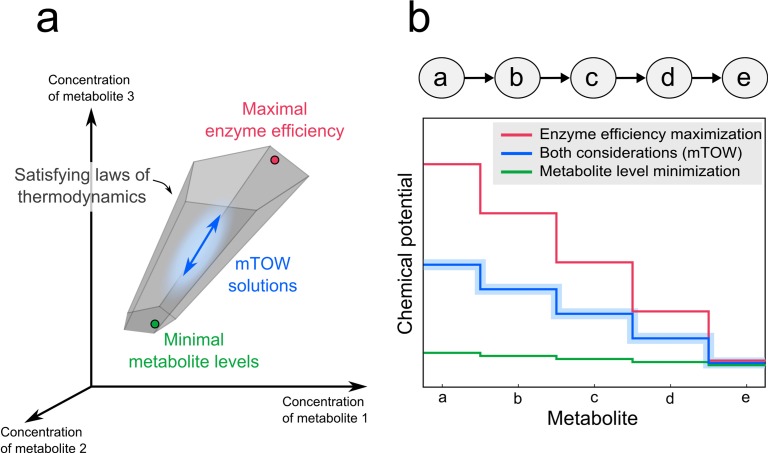
Steady-state metabolite concentrations reflect a balance between minimizing metabolite levels versus maximizing enzyme efficiency.(a) The second law of thermodynamics alone is insufficient to uniquely determine metabolite concentrations, resulting in a space of possible metabolite levels. Two factors “pull” metabolite levels within this space in different directions: (I) a limitation of the solvent capacity and osmotic pressure that tends to drive metabolite concentrations down; (II) the cost associated with the production of enzymes that drives up ratios of reactant-to-product concentrations, and thereby total metabolite concentrations. (b) A toy example of a linear pathway. The chemical potential of each metabolite in the pathway depends on its concentration and intrinsic energy of formation. A drop in metabolite chemical potential at every step is a thermodynamic requirement for the pathway to carry flux. Considering only the objective of maximizing enzyme efficiency (i.e., forward flux per enzyme), it is desirable to achieve a large drop in chemical potential at each step, but this requires unrealistically high total metabolite concentrations (red line). On the other hand, solutions that minimize total metabolite concentrations result in small drops in chemical potential (with many reactions close to equilibrium), leading to inefficient enzyme utilization (most capacity lost to backwards flux) (green line). This in turn requires unrealistically high enzyme levels to produce the required metabolic flux. mTOW balances both factors (blue line.).